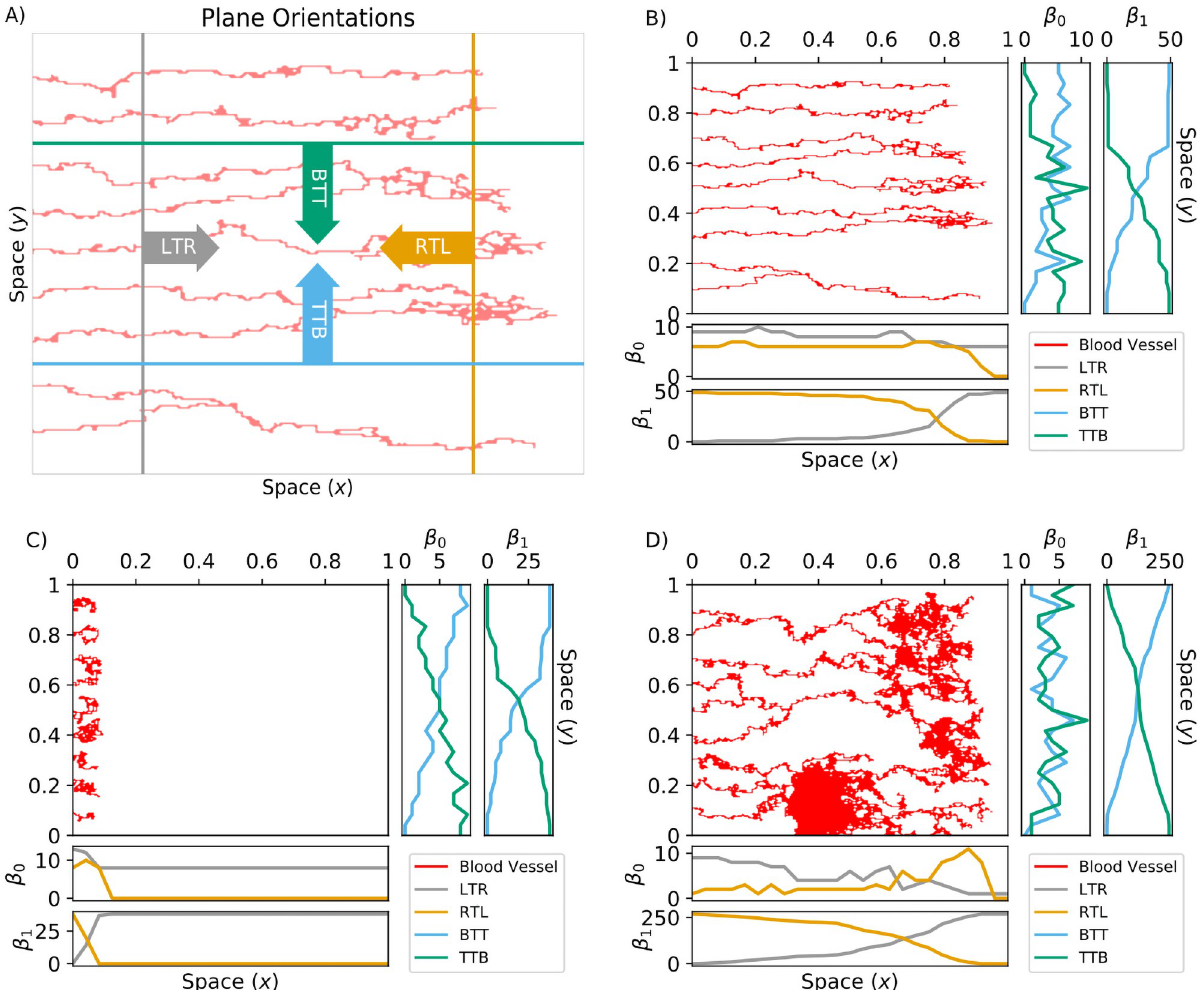
Fig 10. TDA sweeping plane descriptor vectors. A) The sweeping plane directions are left-to-right (LTR, gray); right-to-left (RTL, orange); bottom-to- top (BTT, cyan); and top-to-bottom (TTB, green). For these four v = i T j filtrations, we started with points on the i th boundary and included more points as we stepped towards the j th boundary. Repeating this process produced the spatial filtration K v = K 0 , K 1 ... K end for v = {LTR, RTL, TTB, BTT}. B-D) We formed the Betti curves β 0 ( K v ) and β 1 ( K v ) by computing the Betti numbers along each step of K v for the three blood vessel simulations presented in Fig 7; B) the chemotaxis-driven simulation, C) the haptotaxis-driven simulation and D) chemotaxis and haptotaxis